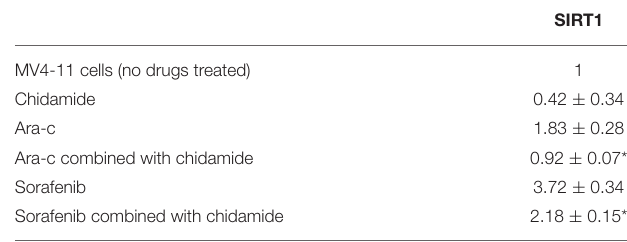
TABLE 6 | The relative value change of SIRT1 mRNA expression in MV4-11 cell lines treated by chidamide, Ara-c, sorafenib, and Ara-c combined with chidamide and sorafenib combined with